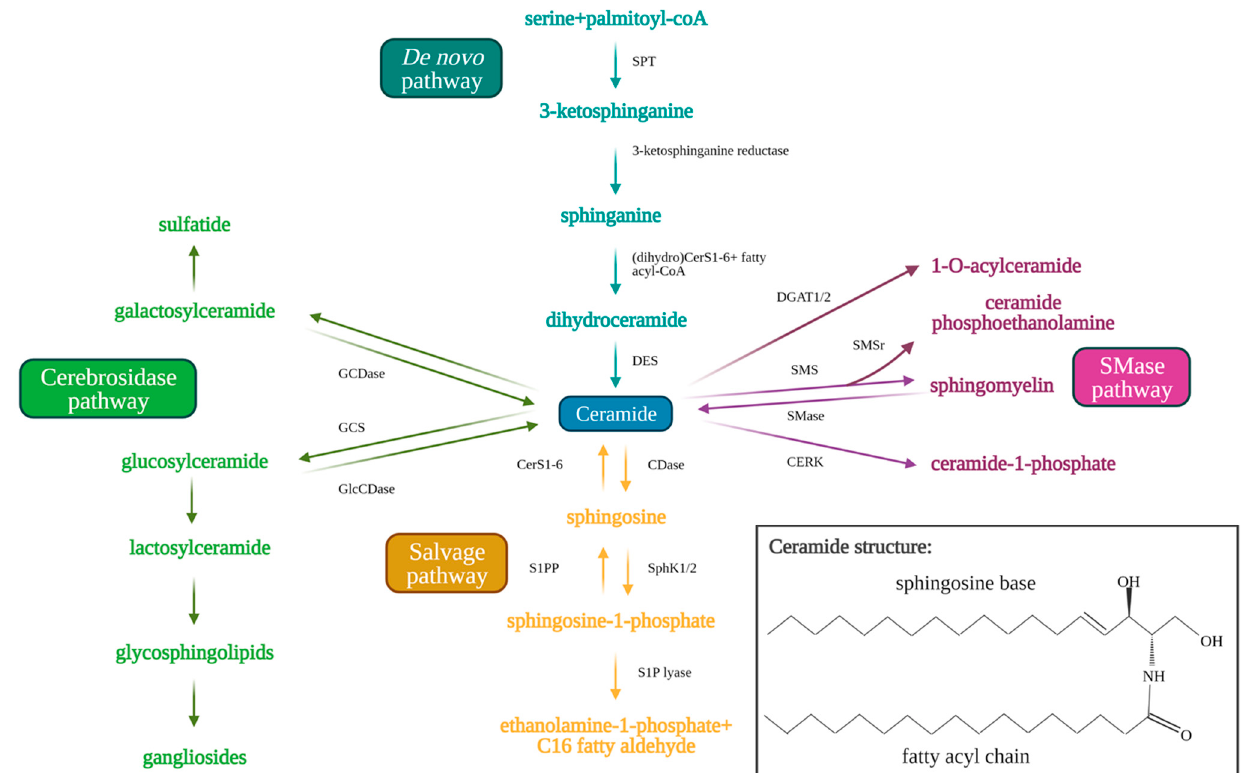
Figure 1. Sphingolipid metabolism pathway. Ceramide acts as the central molecule of the sphingolipid metabolism pathway. Ceramide may be synthesized through either the de novo (blue text and arrows) or the salvage pathway (orange text and arrows). Synthesis of ceramide through the de novo pathway occurs through serine palmitoyltransferase (SPT), 3-ketosphinganine reductase, (dihydro)CerS1-6 (which determine fatty acyl chain length), and finally dihydroceramide desaturase (DES). Ceramide synthesis through the salvage pathway occurs through conversion of sphingosine-1-phosphate by S1P-phosphatase (S1PP) and (dihydro)CerS1-6. Ceramide may be metabolized to produce sphingosine 1-phosphate by ceramidases (CDases) and sphingosine kinase 1/2 (SphK1/2). Sphingosine-1-phosphate can be hydrolyzed by sphingosine 1-phosphate lyase (S1P lyase) to ethanolamine 1-phosphate and C 16 fatty aldehyde. Ceramide may also be used as a substrate for the generation of complex sphingolipids via conversion to glucosylceramide (GlcCer) by glucosylceramide synthase (GCS) (green arrows and text). Glucosylceramidase (GlcCDase) and galactosylceramidase (GCDase) (cerebrosides) catalyze conversion of complex sphingolipids back to ceramide. Ceramide may also be used as a substrate for sphingomyelin through sphingomyelin synthase (SMS) or ceramide 1-phosphate through ceramide kinase (CERK). Sphingomyelin can similarly be broken down by sphingomyelinase (SMase) to produce ceramide once again. Created with BioRender.com (accessed on 11 May